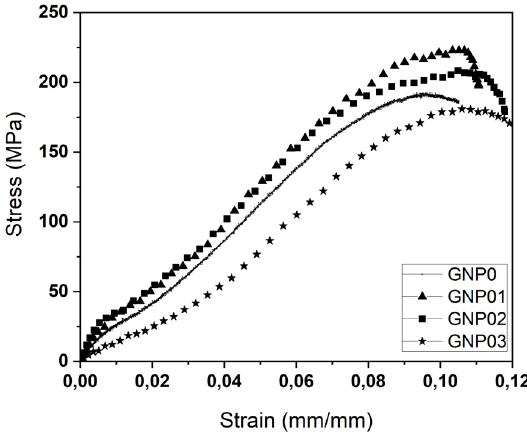
Figure 5. Stress vs strain curves obtained from split Hopkinson pressure bar dynamic testing.